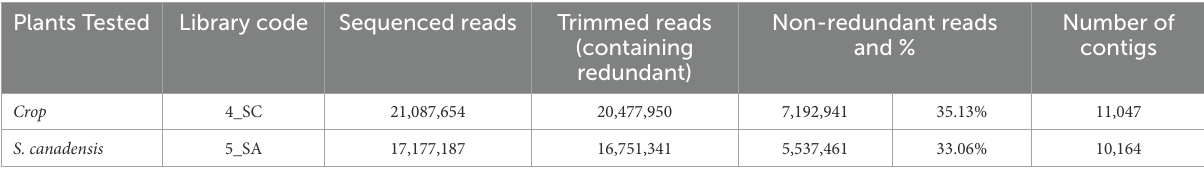
TABLE 1 Samples (millions of sequenced reads) used for small RNA library preparation. Plants Tested Library code Sequenced reads Trimmed reads